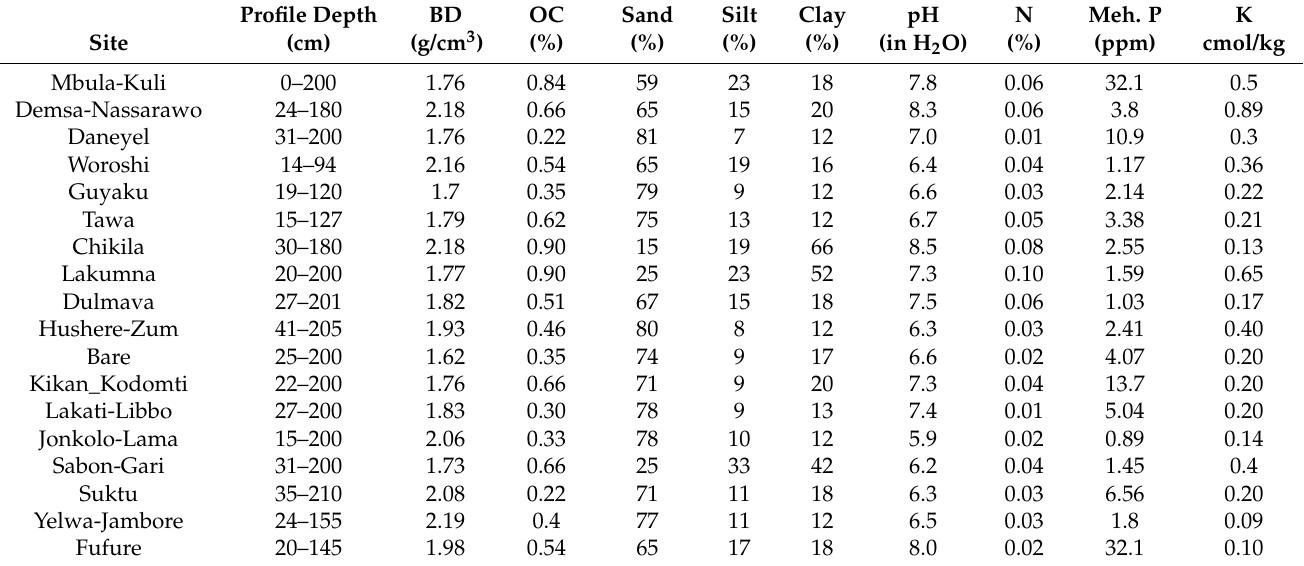
Table 3. Physical and chemical properties used for model applications in Adamawa